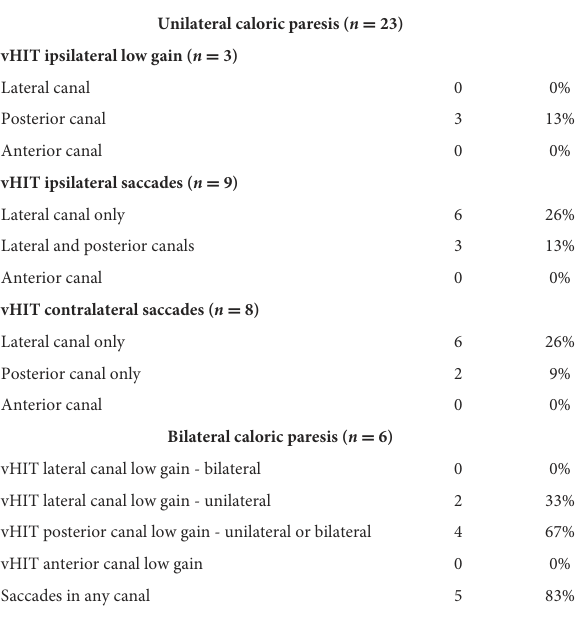
TABLE 2 Caloric paresis and dissociated findings on